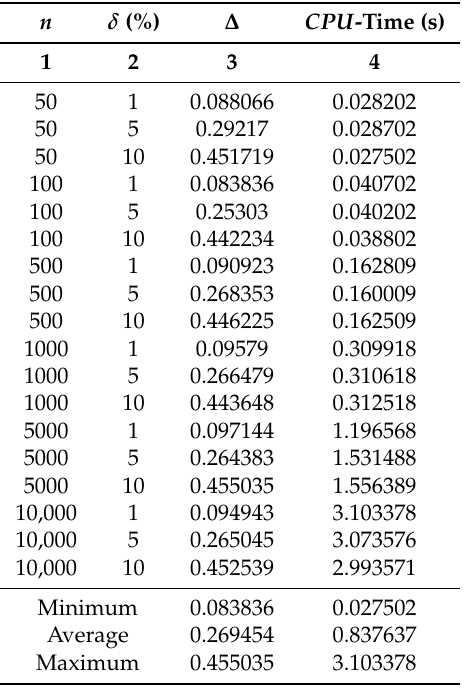
Table 2. Computational results for randomly generated instances with a single block (class